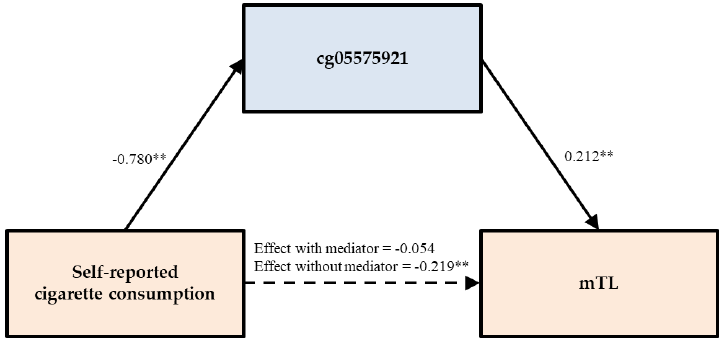
Figure 3. cg05575921 fully mediates the impact of self-reported cigarette consumption on mTL. Note. Chi-square = 41.539, df = 7, p = 0.000; CFI = 0.950; SRMR = 0.024. Values are standardized parameter estimates. ** p ≤ 0.01; * p ≤ 0.05 (two-tailed tests).